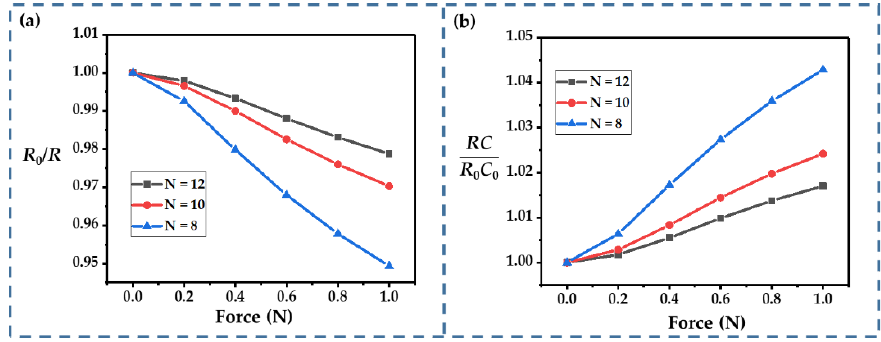
Figure 7. ( a , b ) Influence of the number of fingers on R 0 / R and RC / R 0 C 0 .